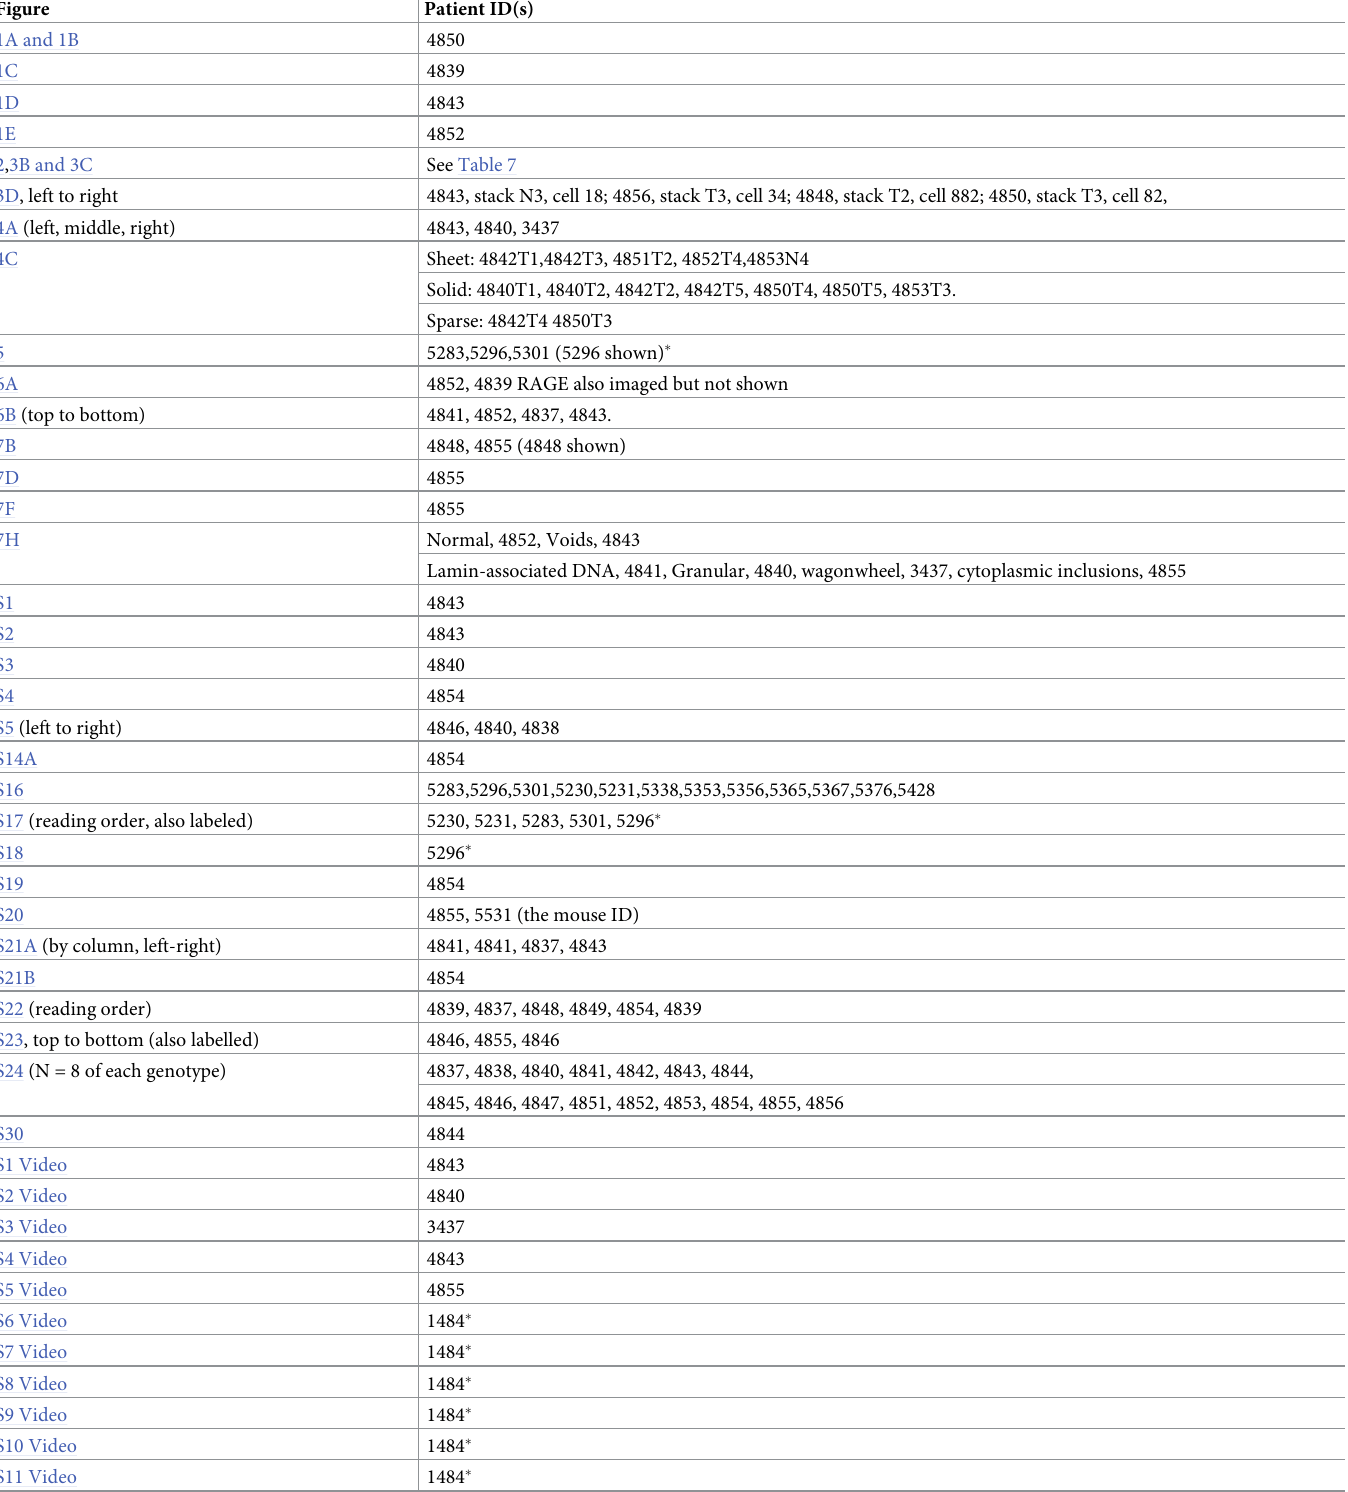
Table 5. Patient identifiers corresponding to data used to create each image shown and select figures.